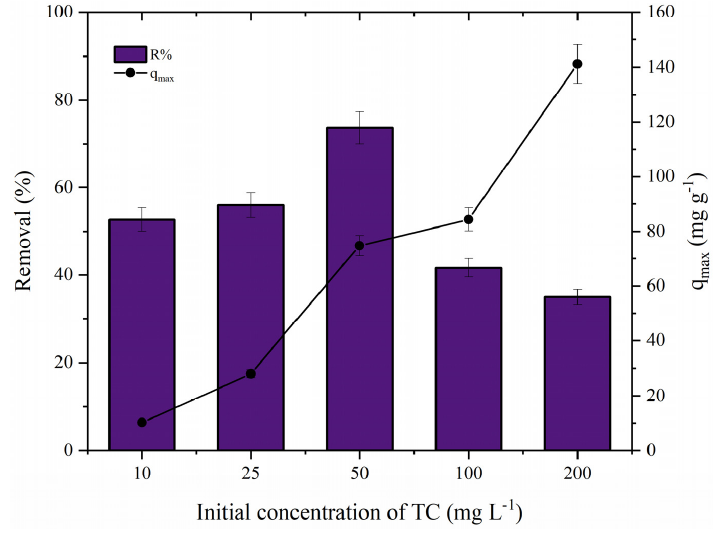
Figure 8. Effect of the initial concentration of TC (CS · Fe 3 O 4 dosage (0.5 g L − 1 ), C 0 = 10–200 mg L − 1 , pH = 7.0, and 293.15 K).